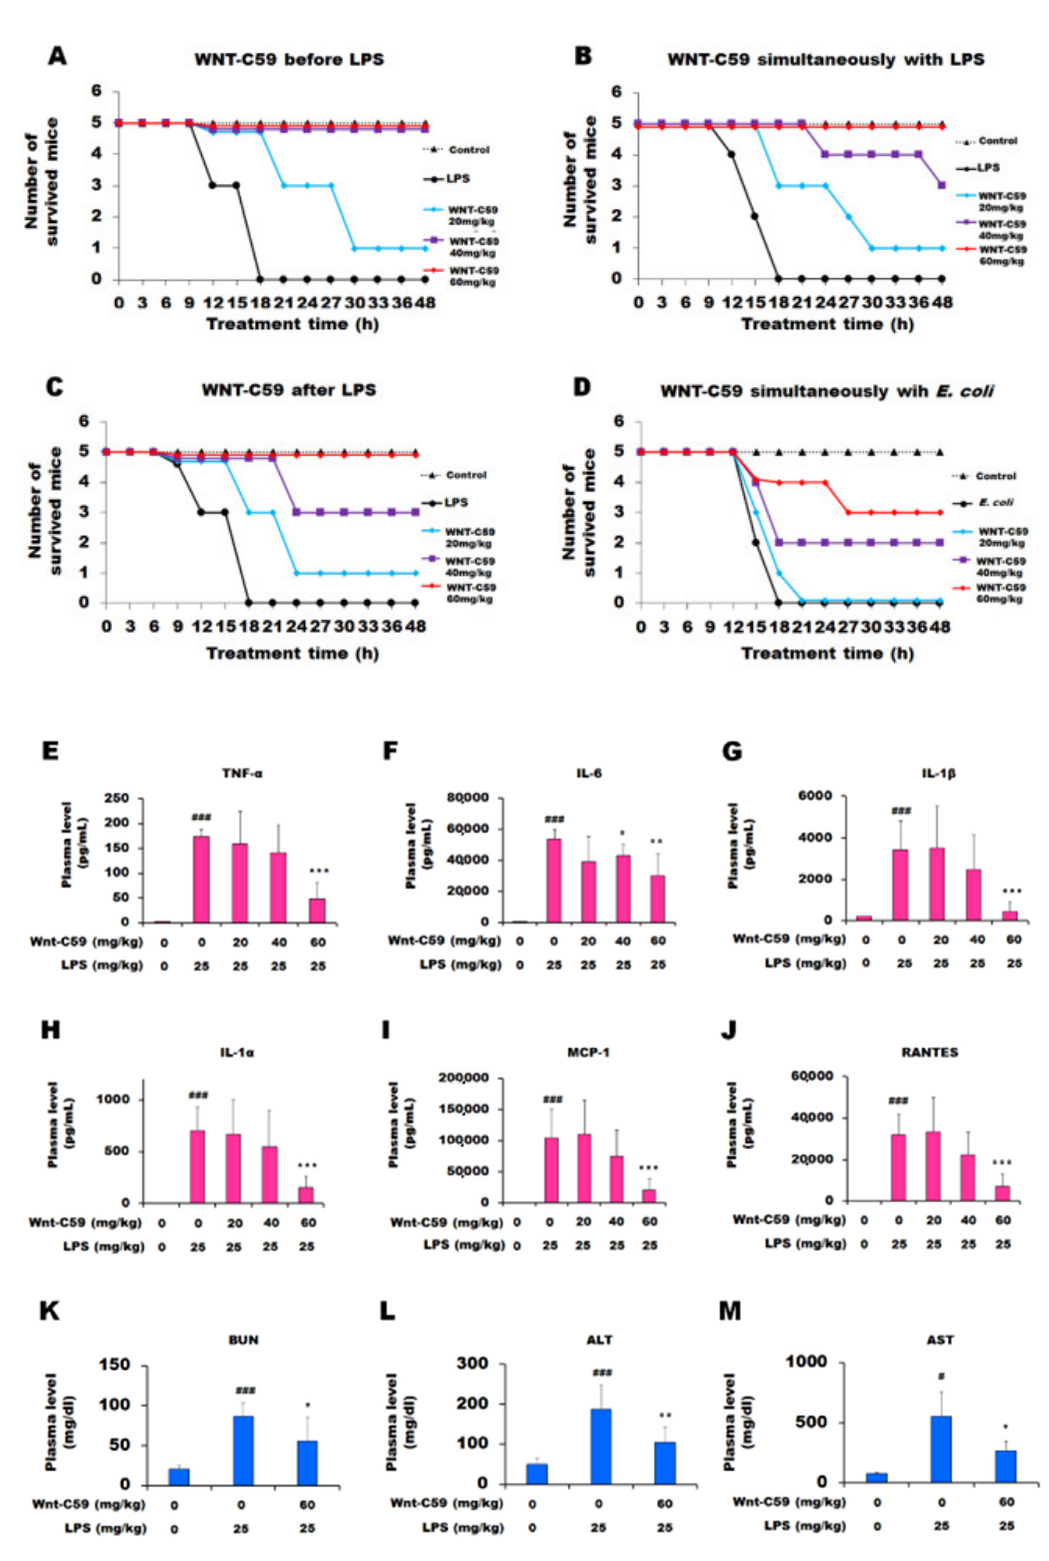
Figure 1. Wnt-C59 reduced the lethality and plasma levels of proinflammatory cytokines and organ-damage biomarkers in endotoxemic mice. ( A – D ) Wnt-C59 suppressed the lethality of endotoxemic mice ( n = 5). C57BL/6 mice were i. p. injected with 0, 20, 40, or 60 mg/kg of Wnt-C59 ( A ) 2 h before, ( B ) simultaneously with, or ( C ) 1 h after injecting 25 mg/kg of lipopolysaccharide (LPS). ( D ) Wnt-C59 at 0, 20, 40, or 60 mg/kg was i. p. injected simultaneously with 10 11 viable E. coli cells. The control group was injected with saline. ( E – J ) Plasma cytokine concentrations were measured using a Luminex assay ( n = 7). ( K – M ) The levels of BUN, a kidney-damage biomarker, as well as ALT and AST, liver-damage